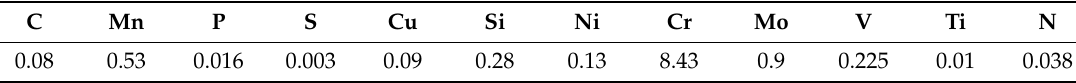
Table 1. Chemical composition of steel Grade 91, wt